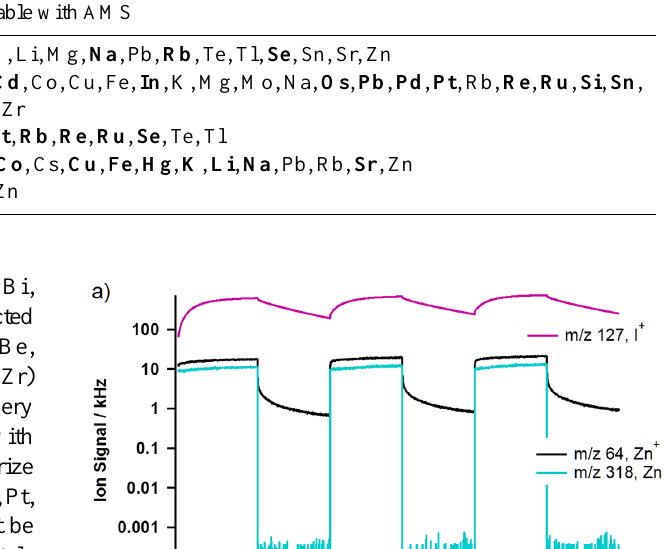
Table 1. Overview of elements which can be expected to be measurable in elemental state or as halide, oxide, nitrate, or sulfate with the AMS based on their melting or thermal decomposition points (Haynes et al., 2015). Substances which can be expected to be well measurable with the AMS (group I) are printed in bold; substances which are likely to vaporize slowly but can probably still be measured with the AMS (group II) are printed in normal font.